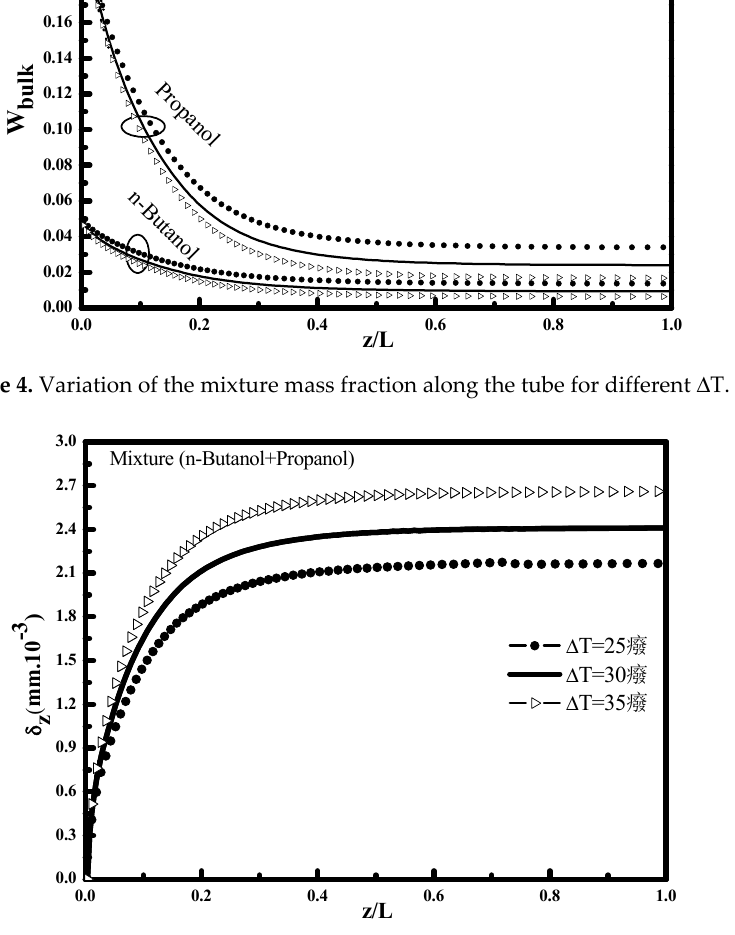
Figure 5. Variation of the liquid film thickness along the tube for different Δ